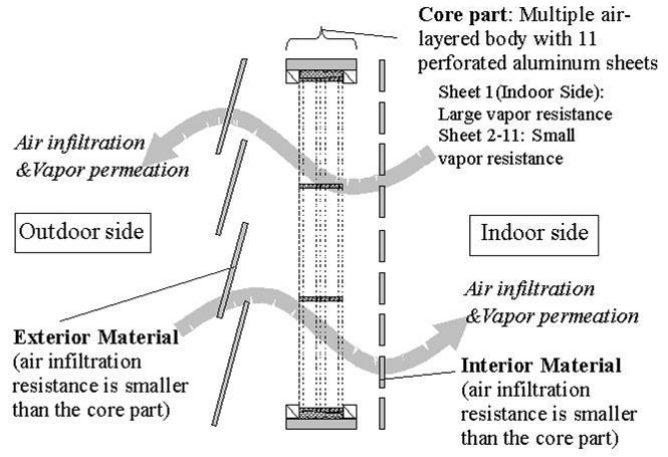
Figure 1. Basic structure of a BAM.